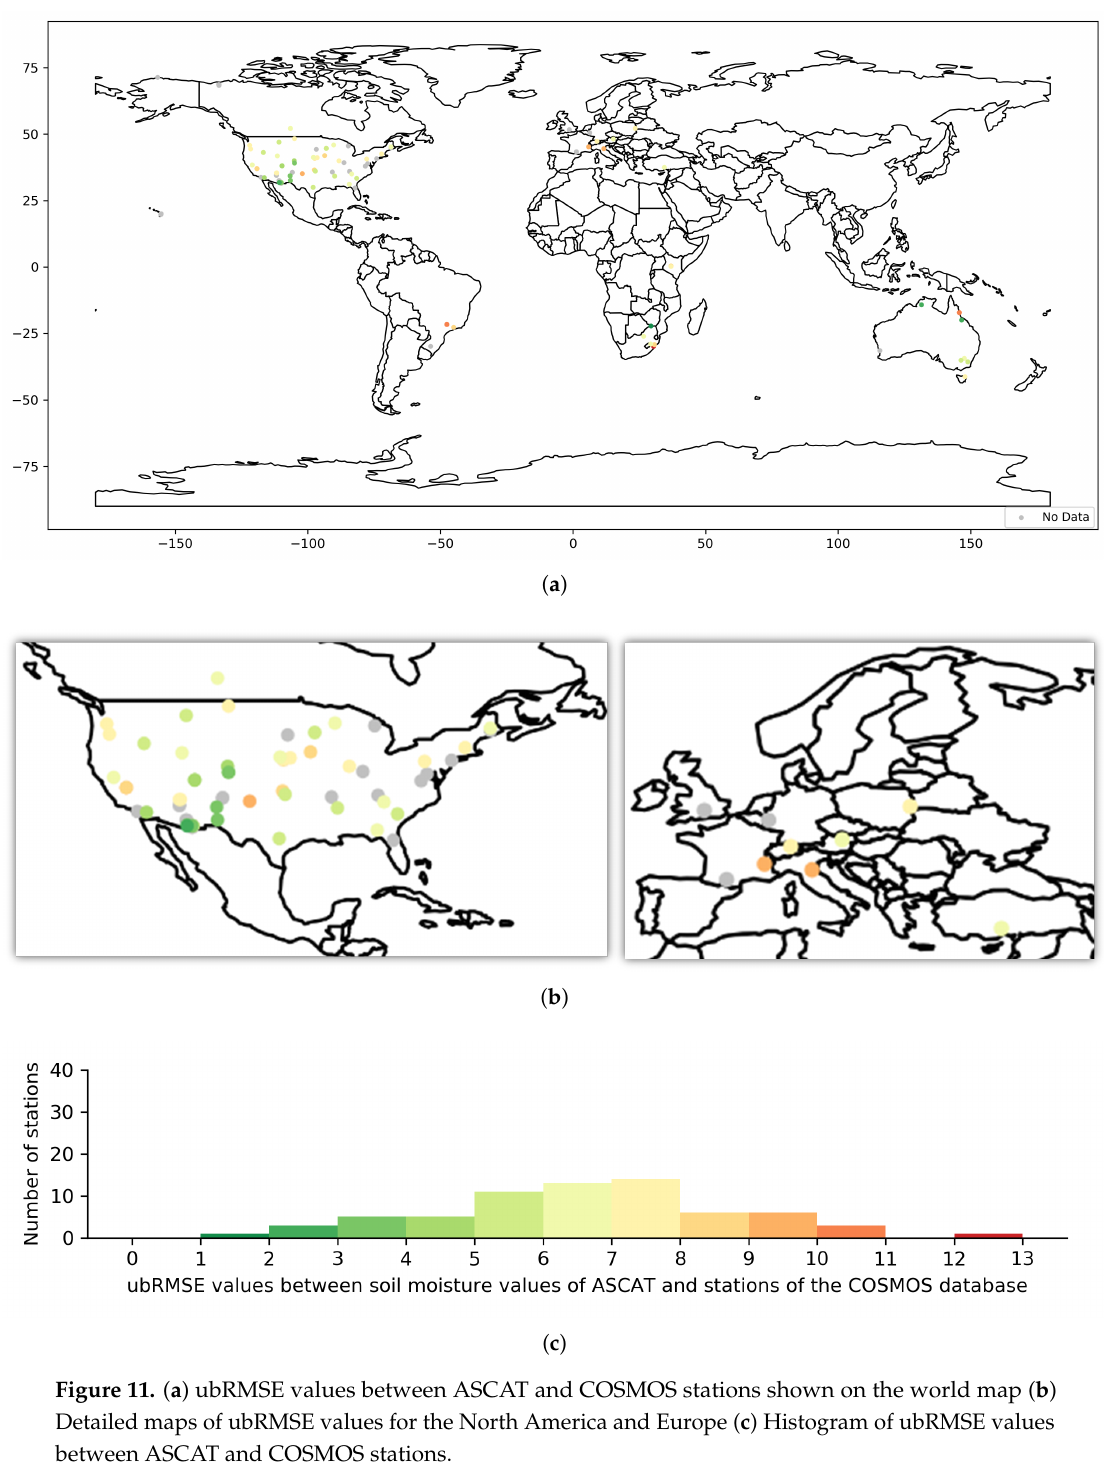
Figure 11. ( a ) ubRMSE values between ASCAT and COSMOS stations shown on the world map ( b ) Detailed maps of ubRMSE values for the North America and Europe ( c ) Histogram of ubRMSE values between ASCAT and COSMOS